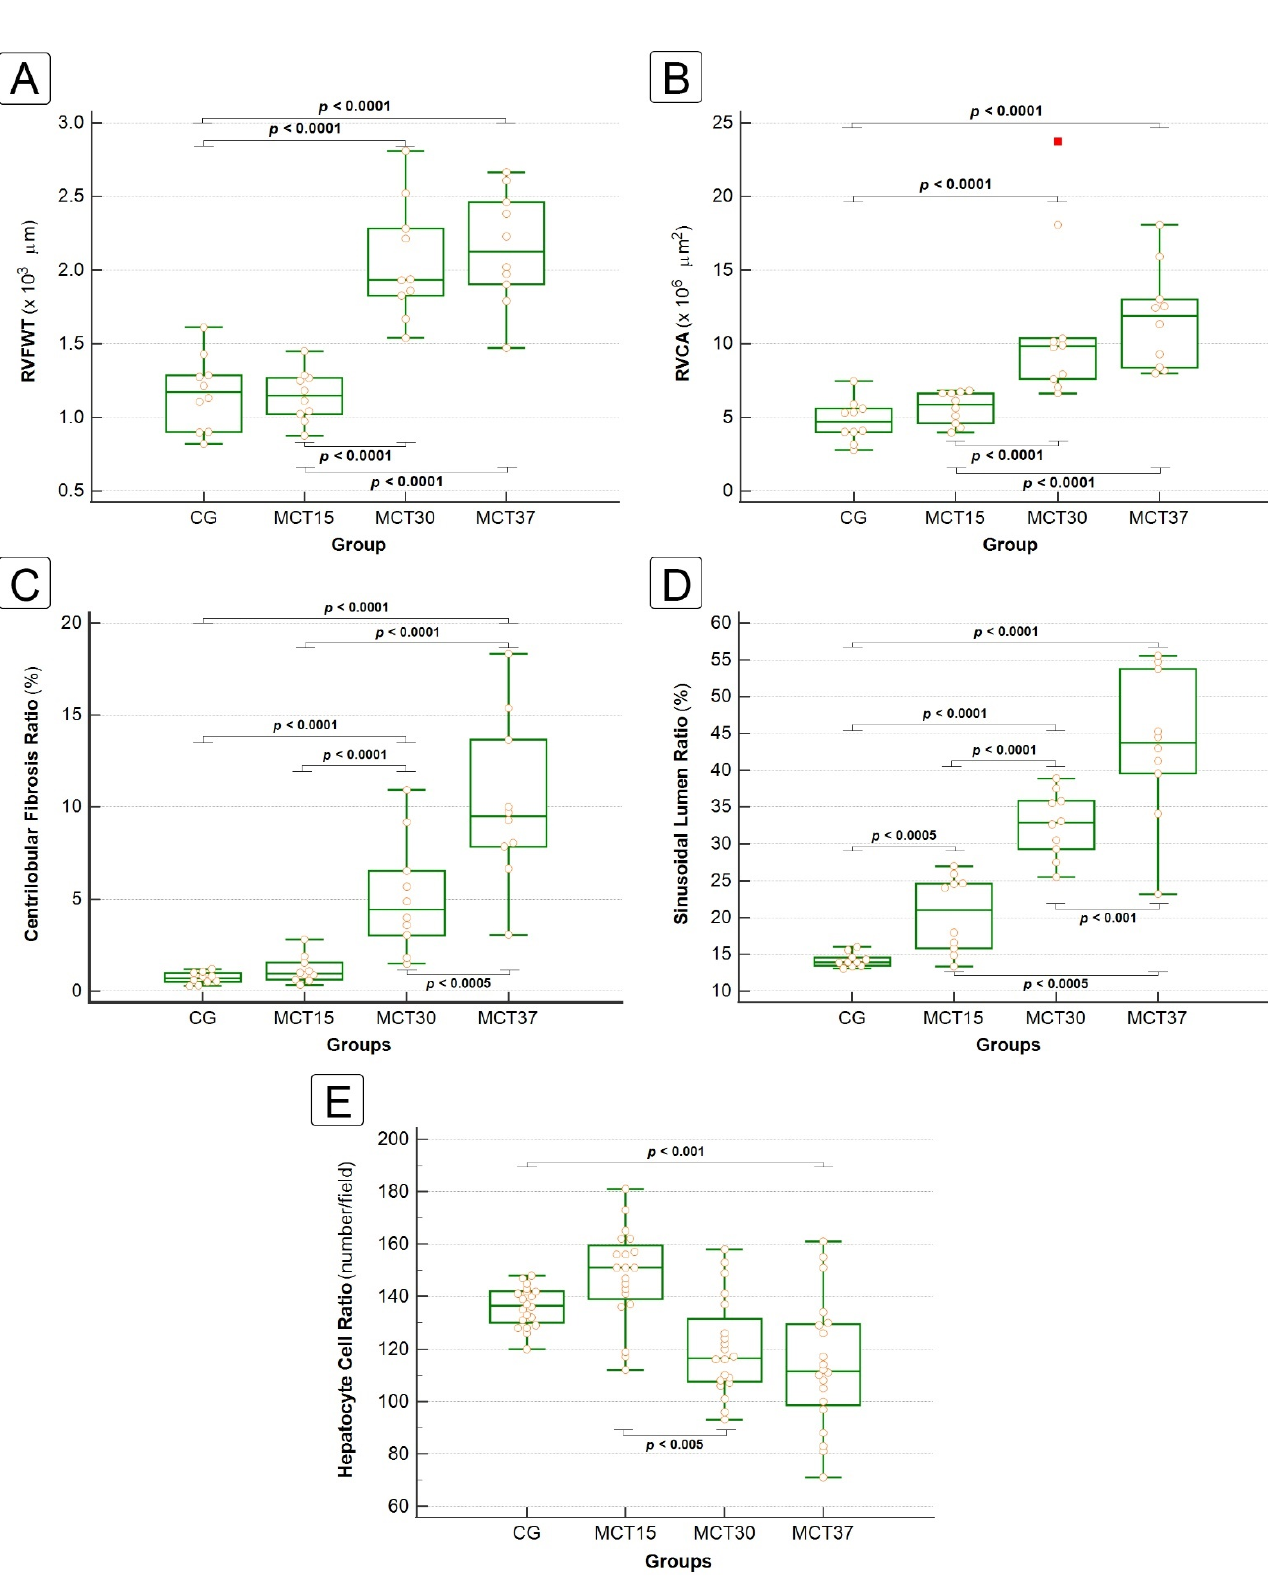
Figure 4. Cardiac and hepatic morphometric analysis. The box-plot graphs (median and interquartile range) show right ventricular free wall thickness (RVFWT) ( A ), right ventricle chamber area (RVCA) ( B ), centrilobular fibrosis ratio ( C ), sinusoidal lumen ratio ( D ) and hepatocyte cell ratio ( E ). ( A – D ) p -values were obtained using the Kruskal–Wallis method followed by the Simes–Hochberg method. ( E ) p -values were obtained by ANOVA one-way with Tukey’s post-hoc test.